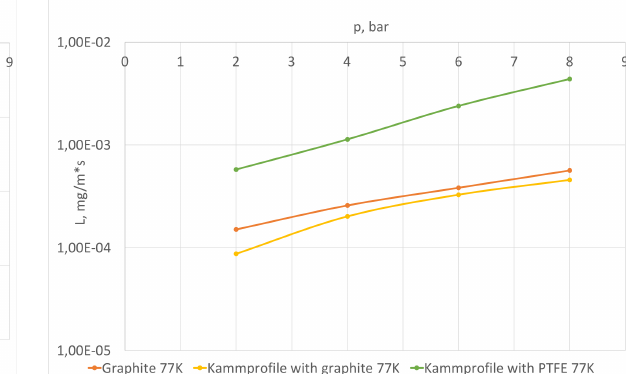
Figure 10: Characteristics of helium leakage from the flanged joint gasketed whit particular gaskets at room temperature.